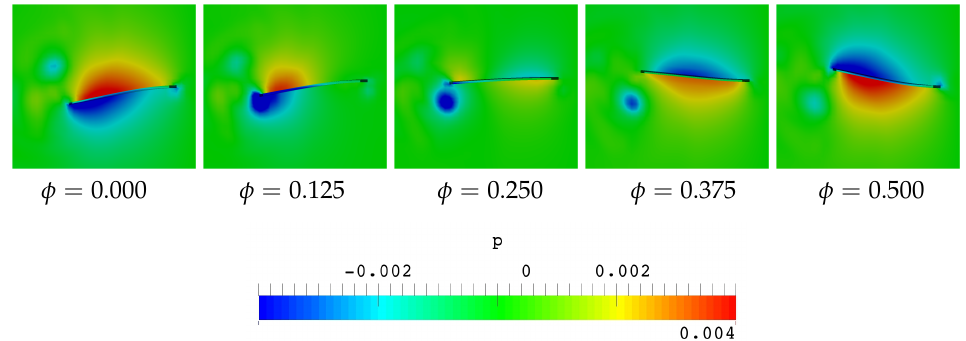
Figure 9. Pressure distributions on the spanwise symmetry plane of the plate during a half-flapping cycle for the case of f ∗ = 0.93 (case